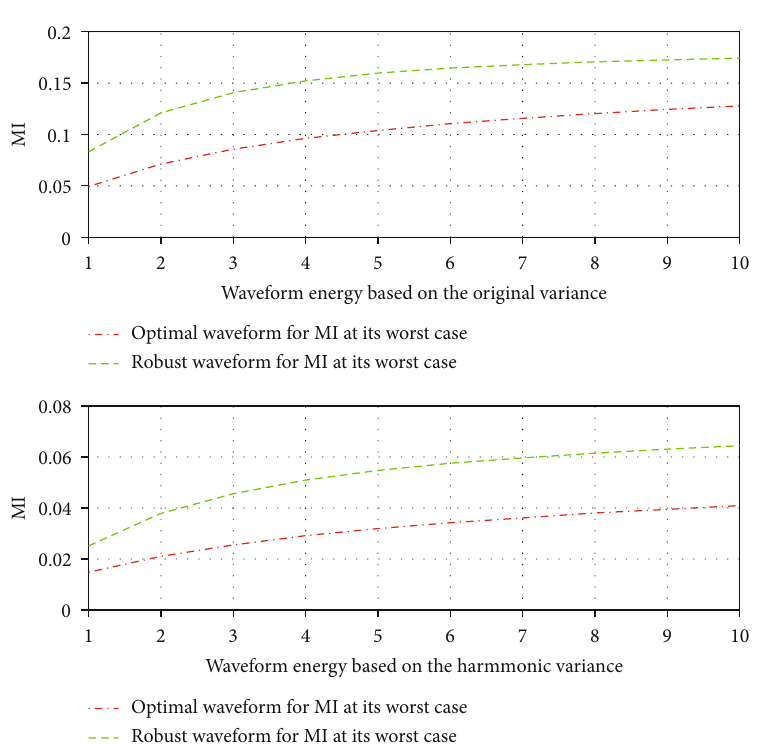
Figure 6: MI comparison of three targets based on the original variance and harmonic